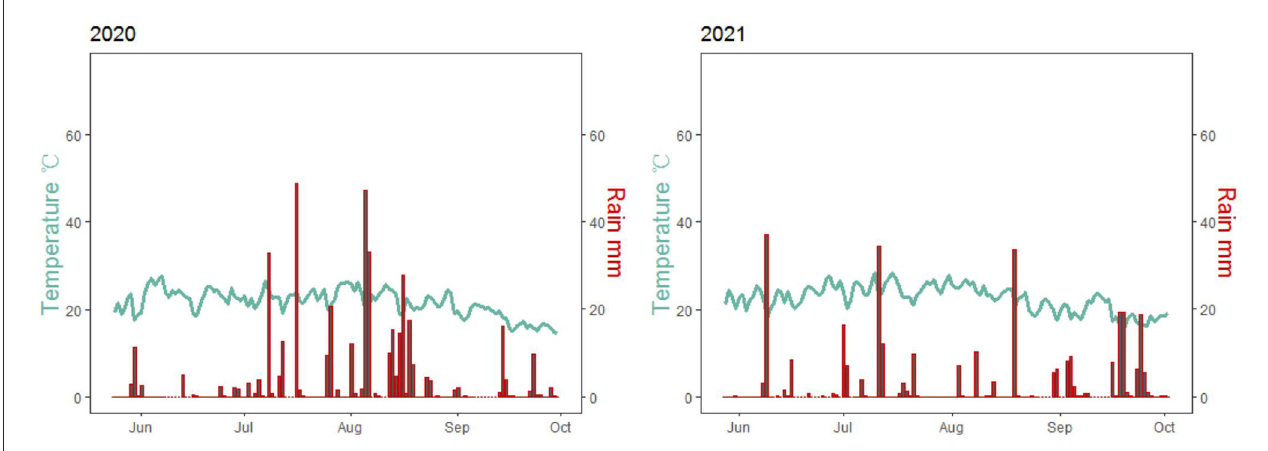
FIGURE1 Average daily temperature and rainfall during growing seasons in 2020 and